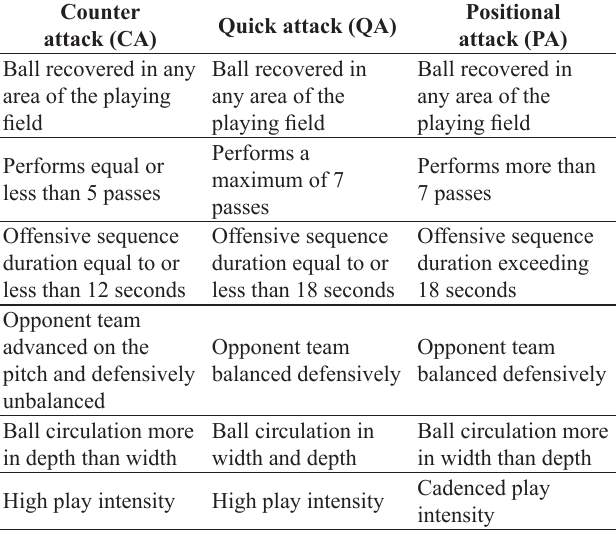
Table 2. Characteristics of Offensive Game Methods.